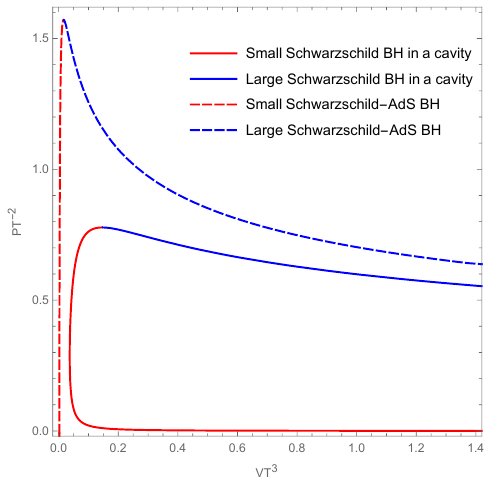
Figure 3 . Plot of the equations of state for a Schwarzschild black hole in a cavity and a Schwarzschild-AdS black